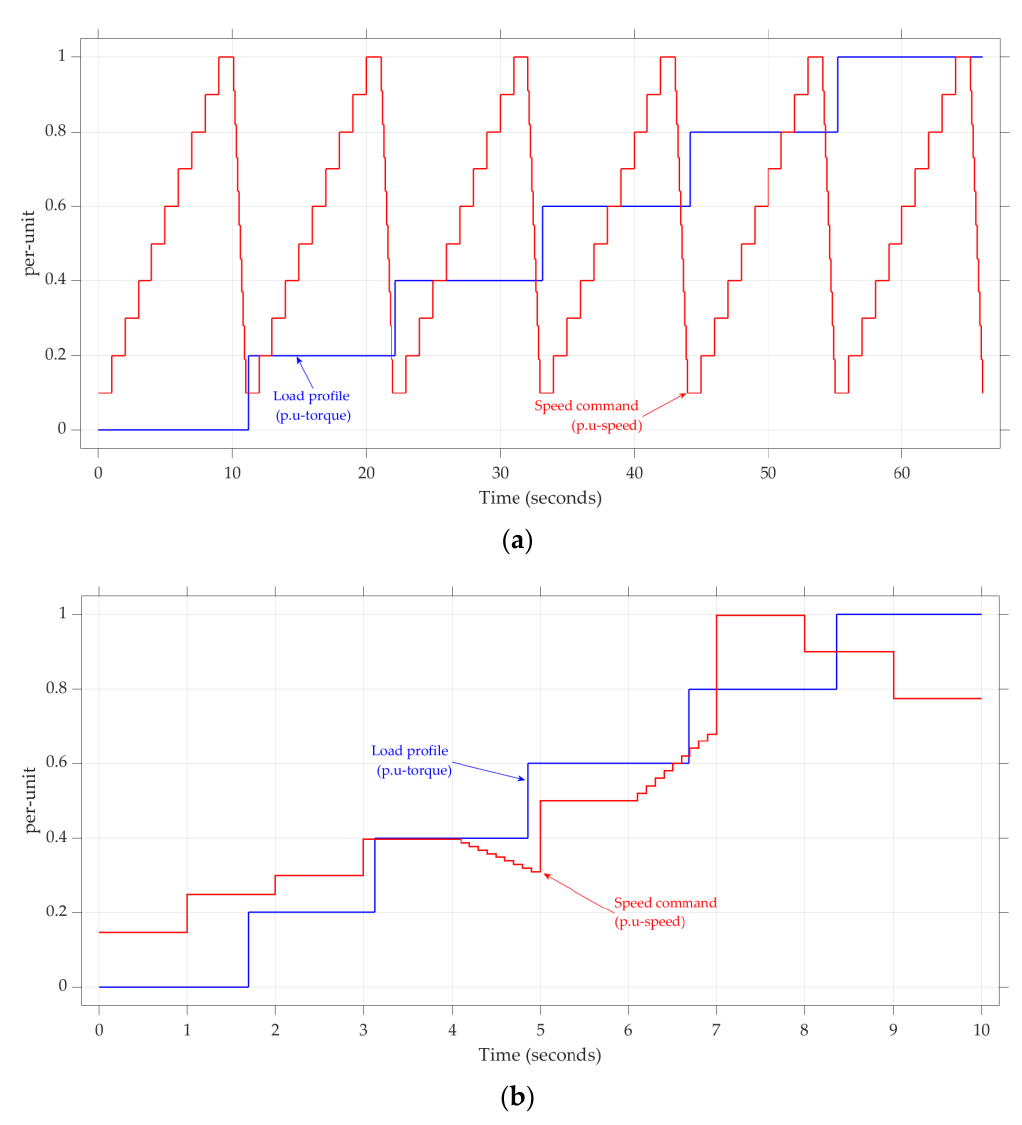
Figure 6. Speed commands and load profile settings for ( a ) training and ( b ) validation data acquisi- tion.